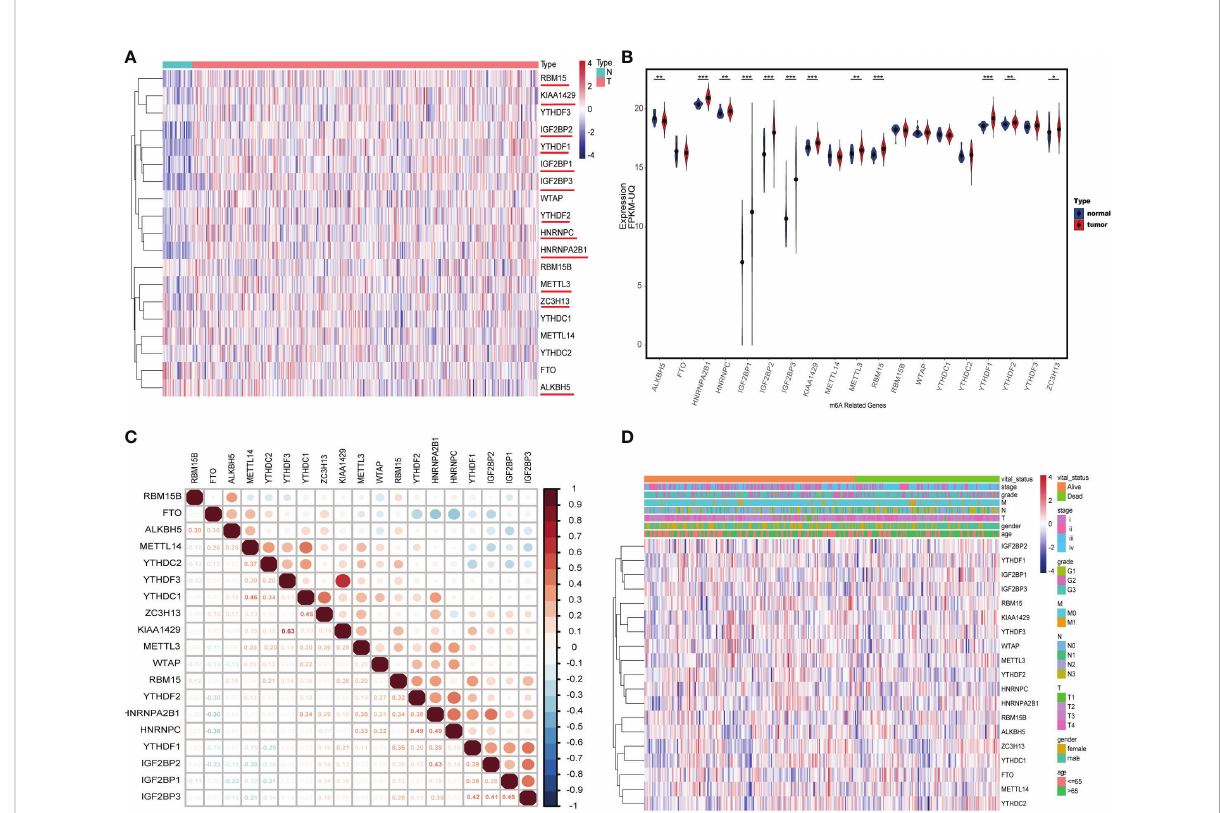
FIGURE 2 The landscape of N6-methyladenosine (m6A) regulator genes in gastric cancer (GC). (A) Heatmap of 19 m6A RNA regulator genes ’ expression in GC. N: solid normal samples, T: tumoral samples. (B) The correlation coef fi cient of 19 m6A RNA regulators. (C) Violin plot visualizing the expression and distribution levels of 19 m6A regulators in GC. (D) Heatmap of 19 m6A RNA regulators ’ expression in tumoral samples in different cohorts including age, gender, stage, grade, T, N, and M. *P < 0.05, **P < 0.01, and ***P <